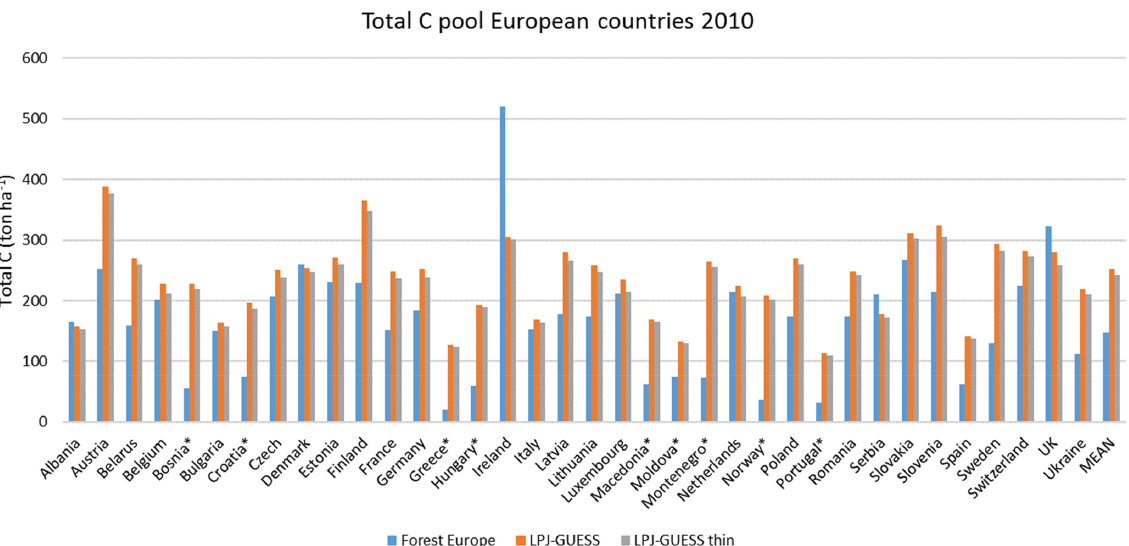
Figure E2. Modelled and observed (Forest Europe, 2015) total carbon pool for individual countries in 2010. LPJ-GUESS is the simulation without thinning. LPJ-GUESS thin is the simulation with automated thinning. ∗ Soil and litter carbon data are missing for Bosnia, Croatia, Greece, Hungary, Macedonia, Moldova, Montenegro, Norway, and